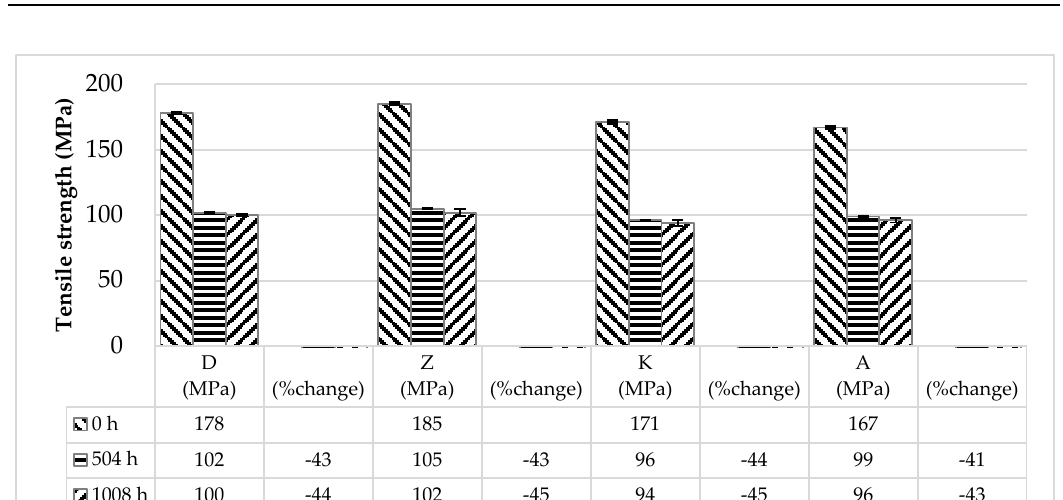
Figure 1. Tensile strength changes of various glass fiber-filled polyamide66 composites with respect to monoethylene glycol (MEG) immersion time increase at 130 °C.